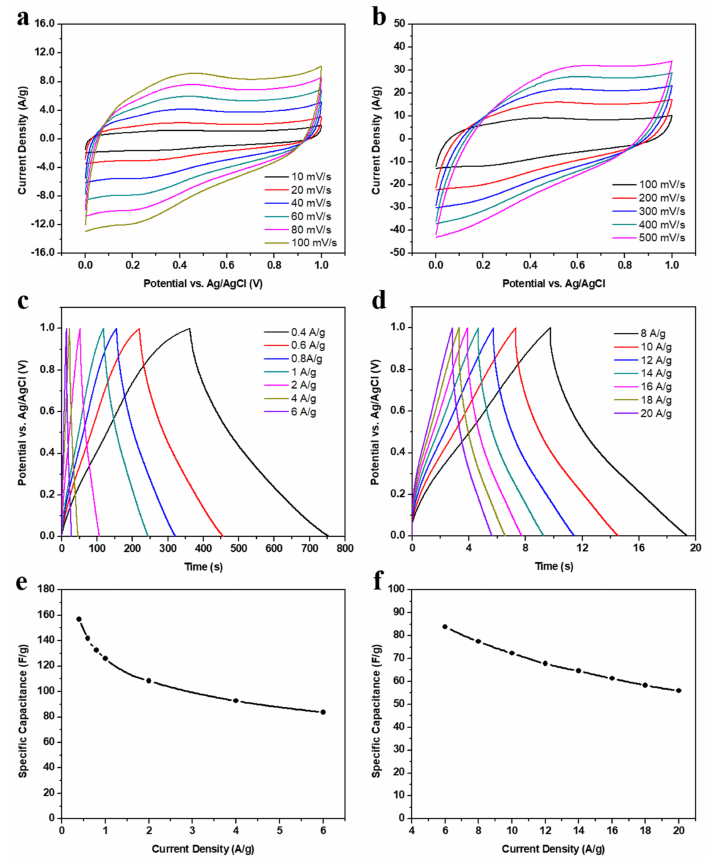
Figure 5. The electrochemical performance of the chemically NaOH-activated carbon electrode; ( a , b ) cyclic voltammetry curves at low and high scan rates, respectively; ( c , d ) galvanostatic charging– discharging plots at low and high current densities, respectively; ( e , f ) specific capacitance functions at low and high current densities,